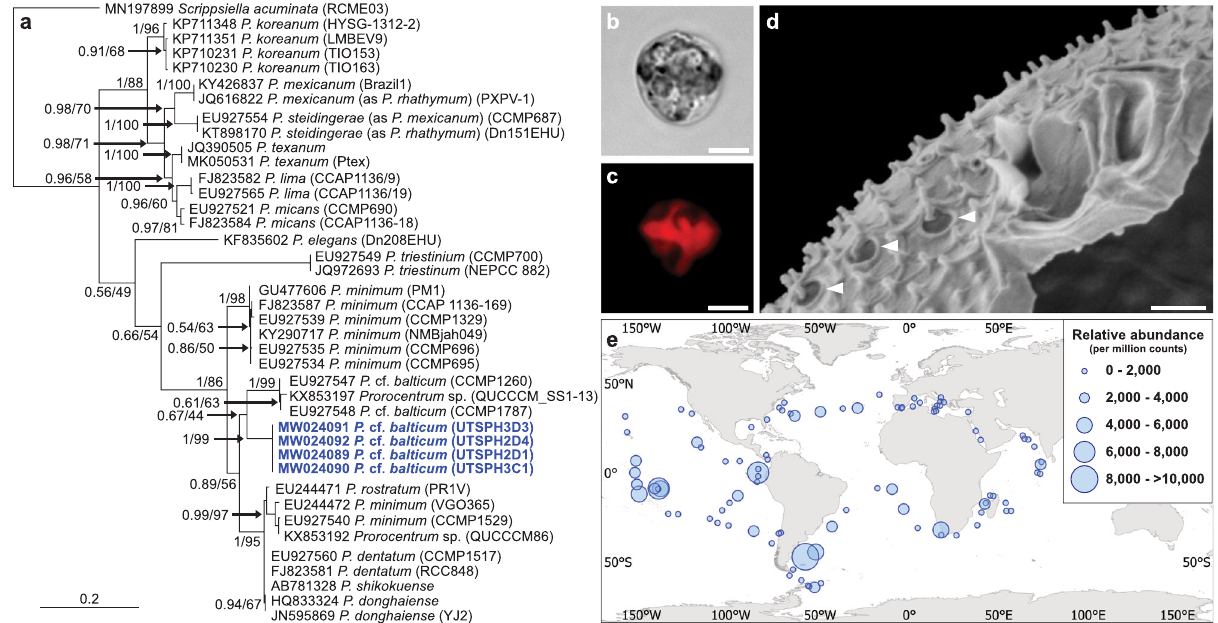
Fig. 1 Identi fi cation and distribution of Prorocentrum cf. balticum . a Maximum Likelihood phylogenetic tree showing alignment of the internal transcribed spacer (ITS) gene region indicating a clear differentiation of the P. cf. balticum strains (blue) from described Prorocentrum species, and the close relation to unde fi ned strains. Accession numbers, species designation, and strain codes are provided for each sequence and values at the nodes represent Bayesian posterior probability and Maximum Likelihood bootstrap support. b , c Light microscope images of P. cf. balticum showing a cell under Differential Interference Contrast (DIC) ( b ) and peripherally located red-auto fl uorescent chloroplasts ( c ). d Scanning Electron Microscope (SEM) image of P. cf. balticum showing distinctive dual wing-like apical projections and unique large pores with emanating large spines (white arrows). Images b , c were taken with an Upright Fluorescence Microscope (Nikon Eclipse Ni, Japan), fi tted with a Cy5 620/60 nm ex 700/75 nm em fi lter and a monochrome camera (Nikon DS-Qi2) under 1000× magni fi cation with oil immersion; scale bar = 5 µ m. Scale bar in d = 0.5 µ m. e Global biogeography of P . cf. balticum produced using the relative abundance of 18S rDNA sequences from the Tara Oceans amplicon